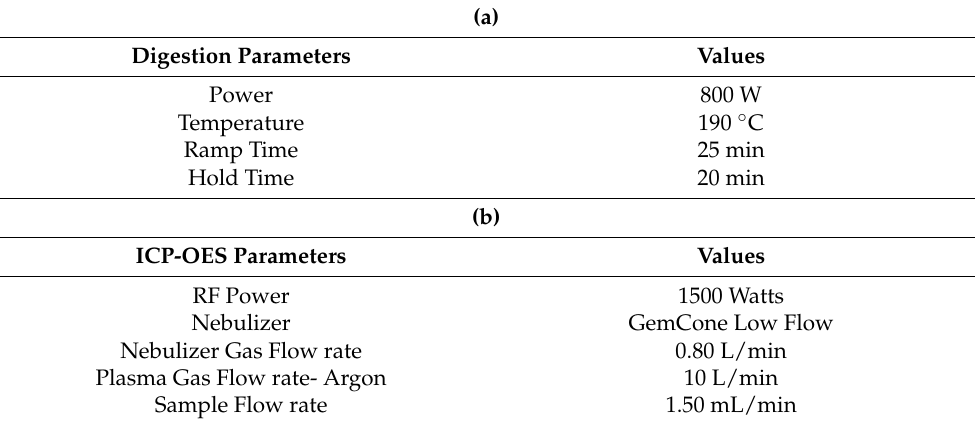
Table A1. Operating conditions for ICP-MS determination of iron in magnetite nanoparticles. ( a ) Parameters for microwave assisted acid digestion of samples. ( b ) Parameters for analysis of Iron by Optima 8300 ICP-OES.